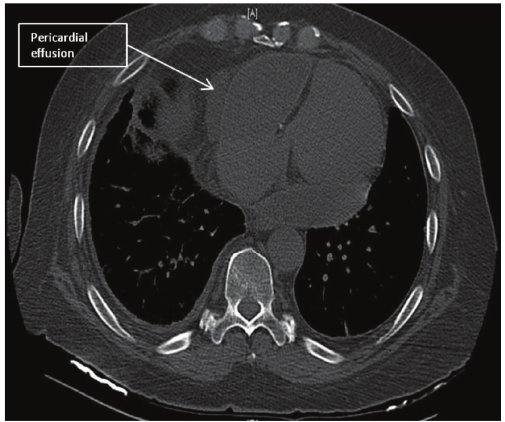
Figure 1: Axial noncontrast CT image of the thorax showing the heart with pericardial effusion.